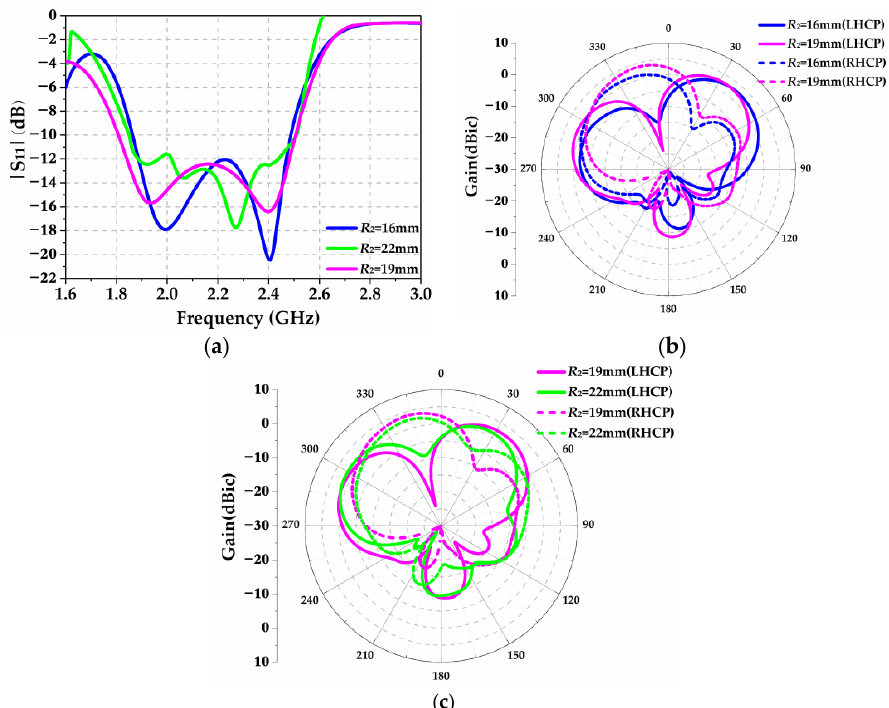
Figure 17. Parameter study of the radius R 2 of the small helix cavity: ( a ) | S 11 | with different R 2 ; ( b ) Radiation patterns with R 2 = 16 mm and 19 mm; ( c ) Radiation patterns with R 2 = 22 mm and 19 mm.